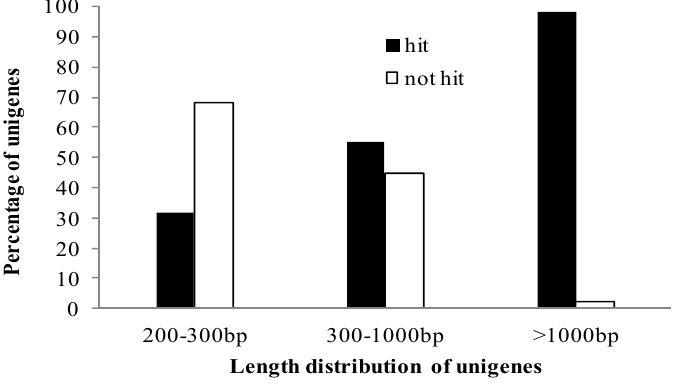
Figure 2. Comparison of unigene length between hit and not-hit unigenes. Longer unigenes were more likely to have BLAST matches in protein databases.